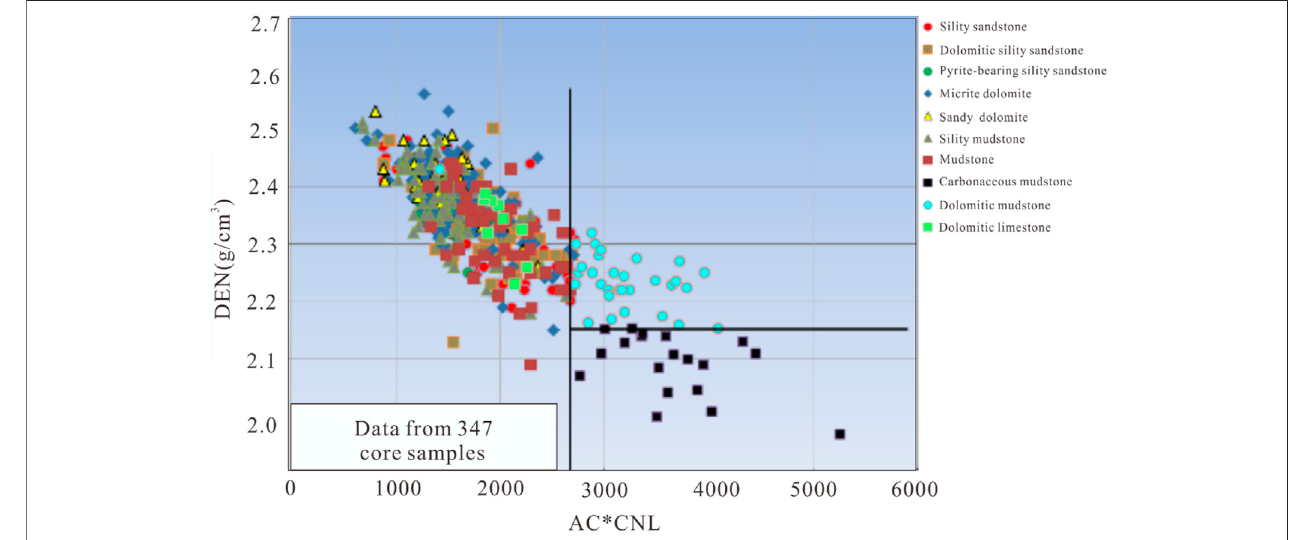
FIGURE 4 | Crossplot of AC × CNL and DEN.